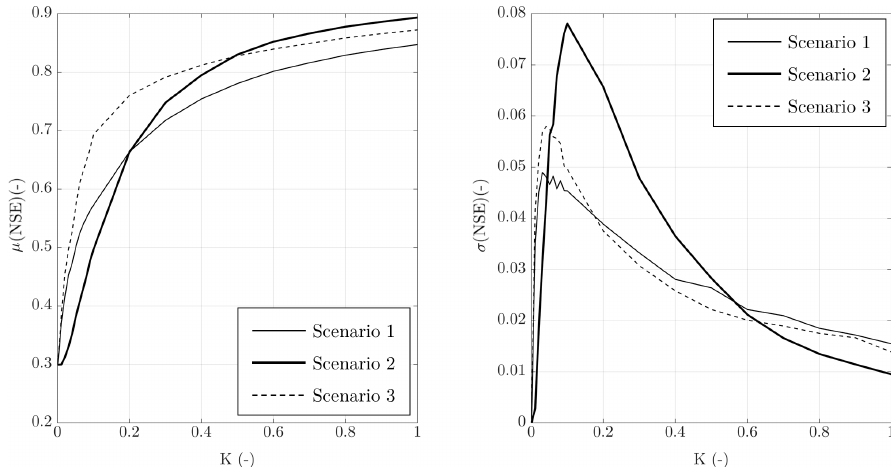
Figure 9. µ ( NSE ) and σ ( NSE ) values obtained considering varying values of K for different involvement